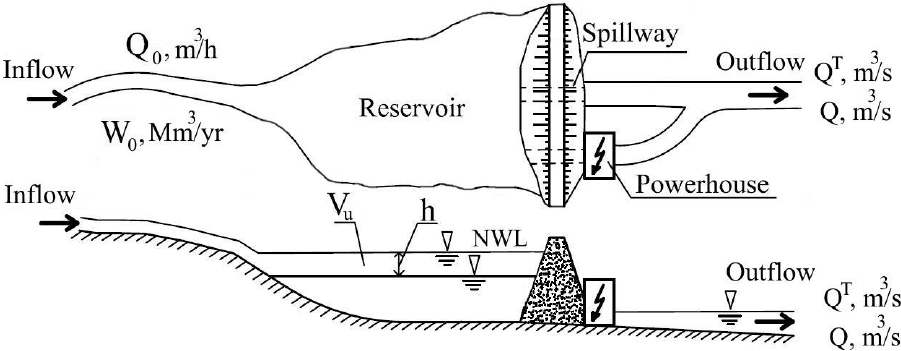
Figure 1. River flow distribution in a hydropower scheme associated with an